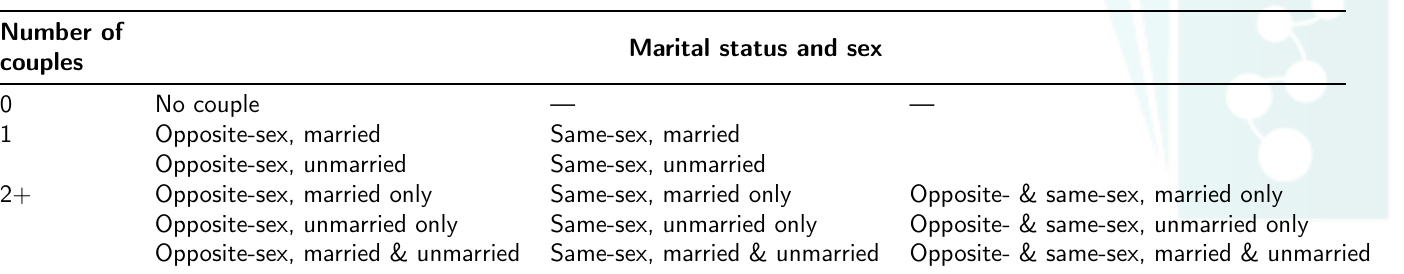
Table B.1: Classification scheme of households by number couples and their